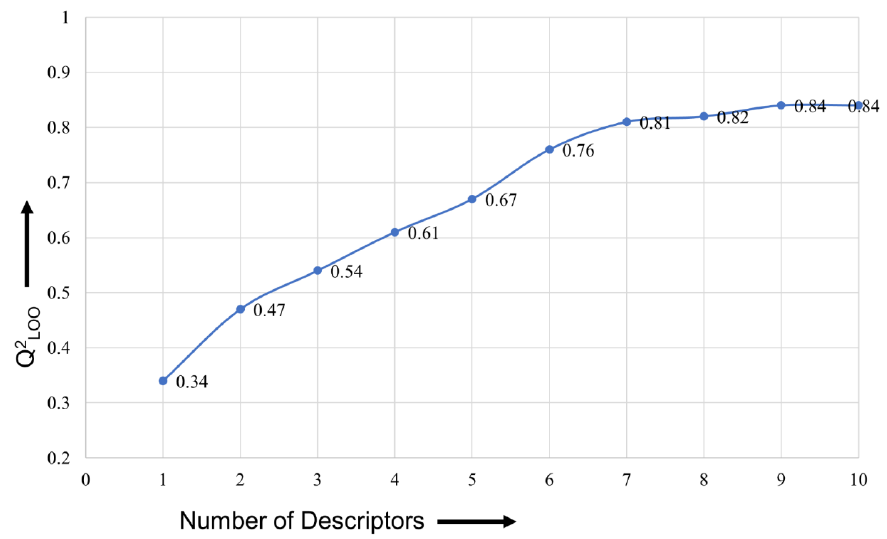
Figure 13. Plot of number of descriptors against leave-one-out coefficient of determination (Q2LOO) to identify the optimum number of descriptors.